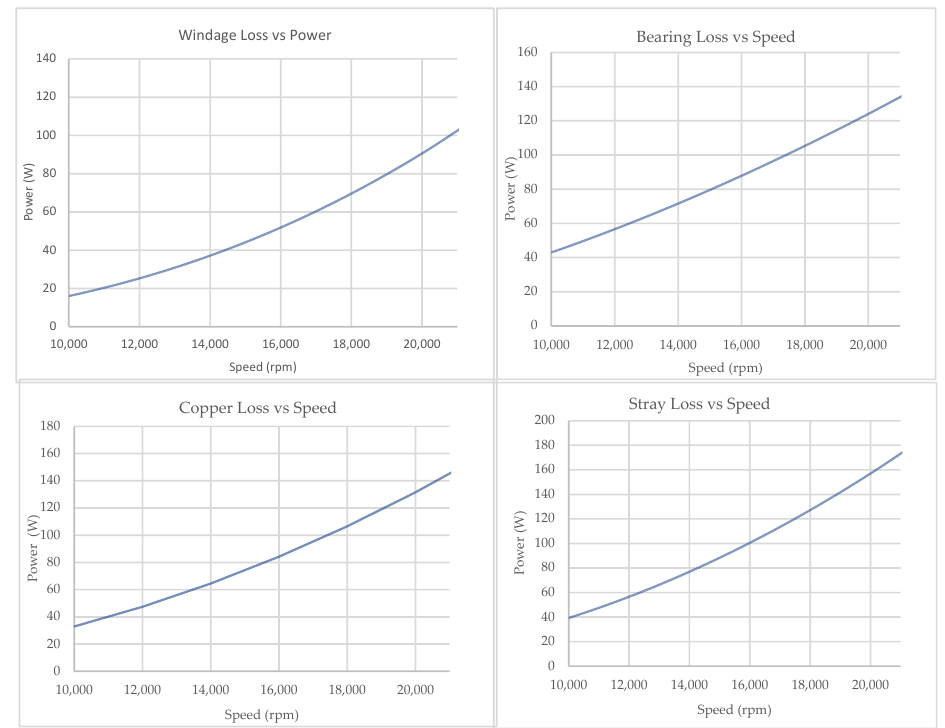
Figure 8. Power loss vs speed: windage loss (top left); bearing friction loss (top right); resistive loss (bottom left); stray loss (bottom right).